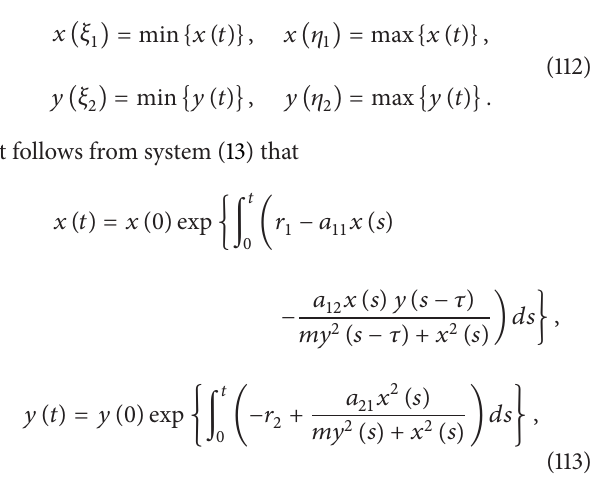
= −(2/9)𝑟 2 1 )/(2𝑟 ) − (4/3)𝑟 ((3/2) − 𝑟 2 2 2 )/(2𝑟 ) 2 2